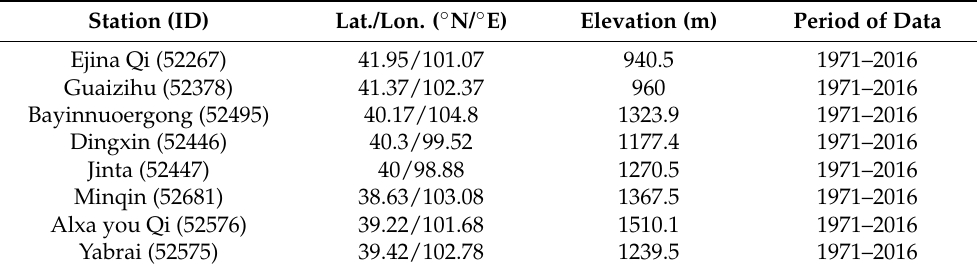
Table 1. Elementary information of the eight meteorological stations around the